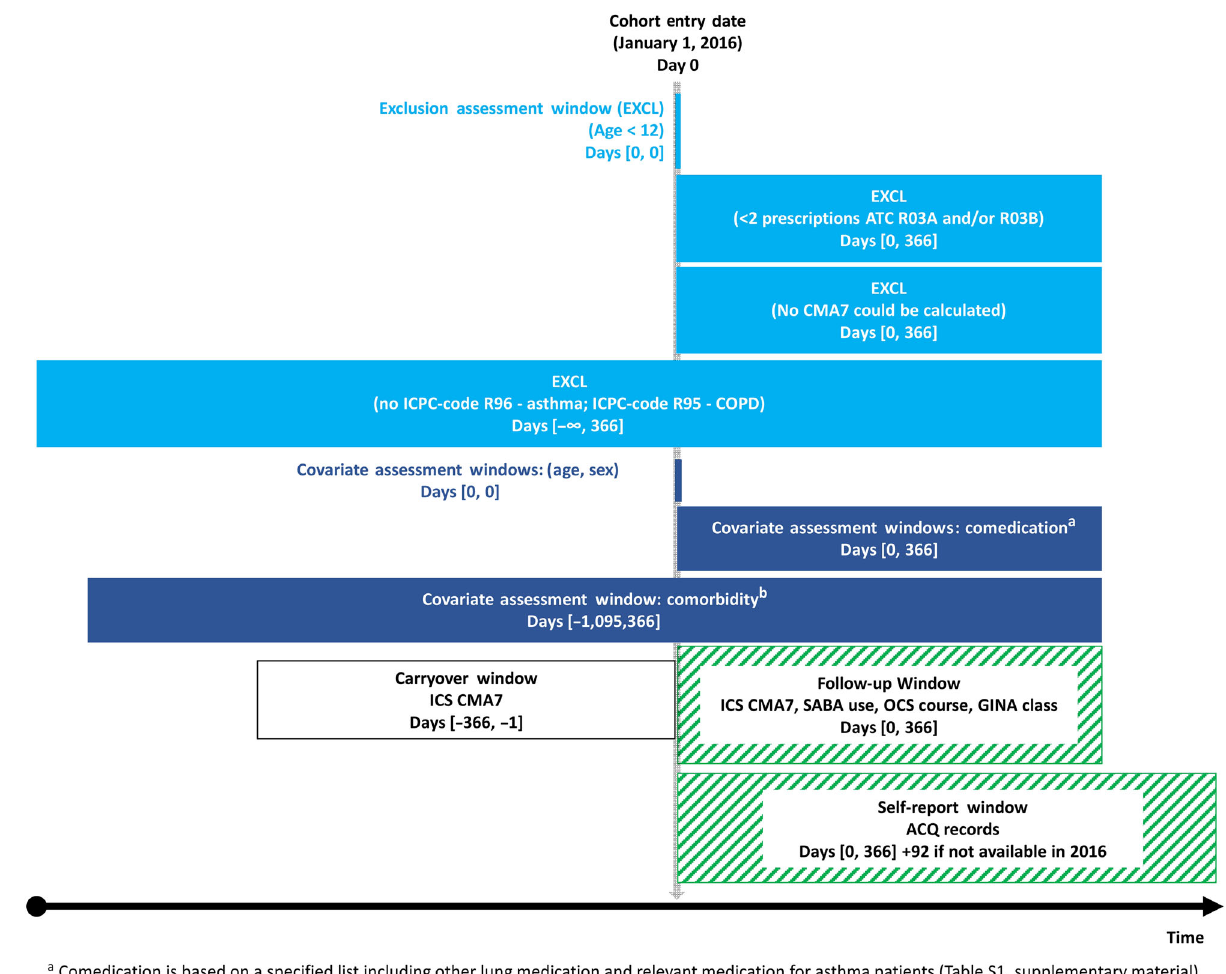
Fig. 1 Study design and